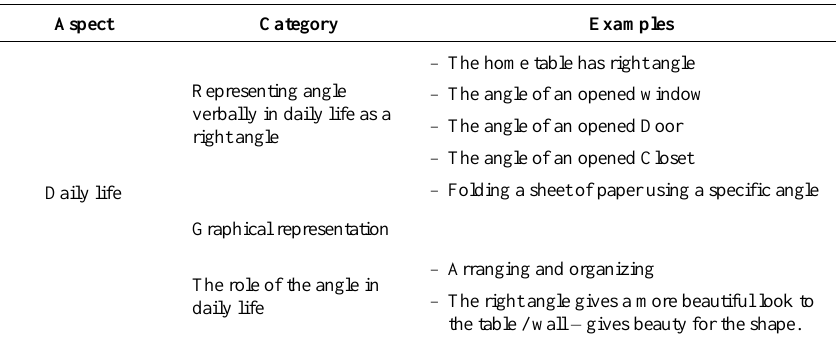
Table 2. Analysis examples of categories taken from the pre-test